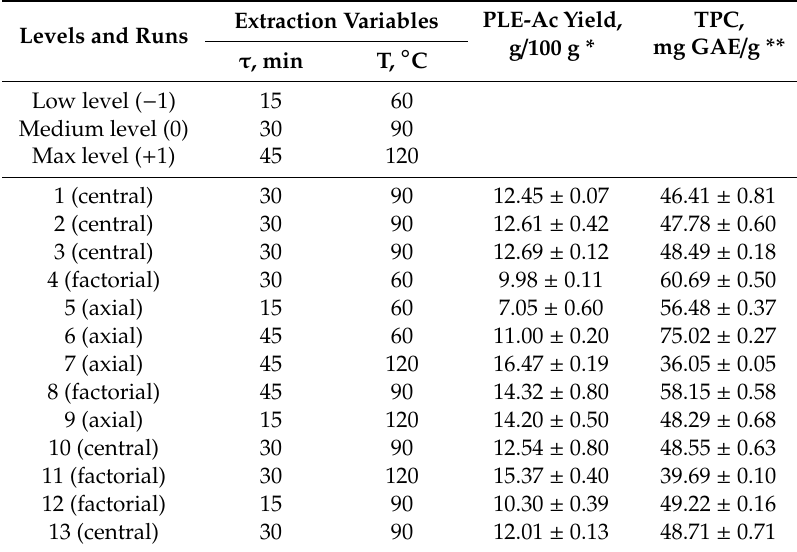
Table 2. Central composite design matrix for the pressurized liquid extraction with acetone (PLE-Ac) optimization of D. fruticosa leaves after SFE-CO 2 (45 MPa, 60 ◦ C, 360 min) and values of observed response factors RF I (PLE-Ac extract yield, g / 100 g of residue after SFE-CO 2 ) and RF II (TPC, mg GAE / g of pomace residue after SFE-CO 2 ). Extraction Variables PLE-Ac Levels and Runs